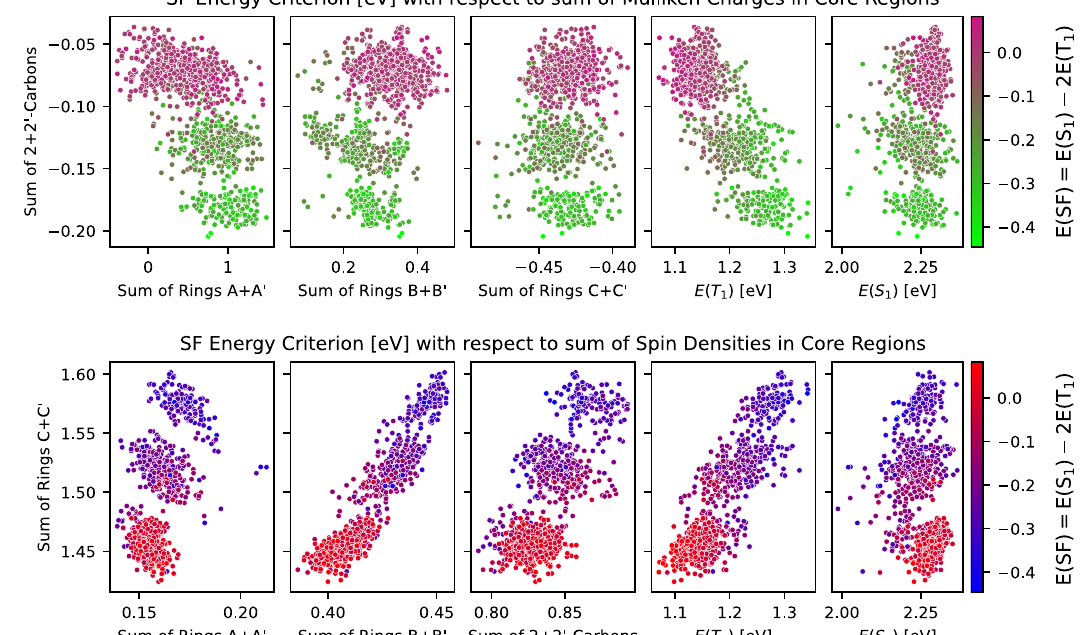
Fig. 6 Distributions of Mulliken charges and spin densities colour coded by the SF criterion energy. (Top) Distribution of summed Mulliken charge over different parts of the molecule and at different excitation energies, colour coded by the SF criterion energy. (Bottom) Distribution of summed spin densities over different parts of the molecule and at different excitation energies, colour coded by the SF criterion